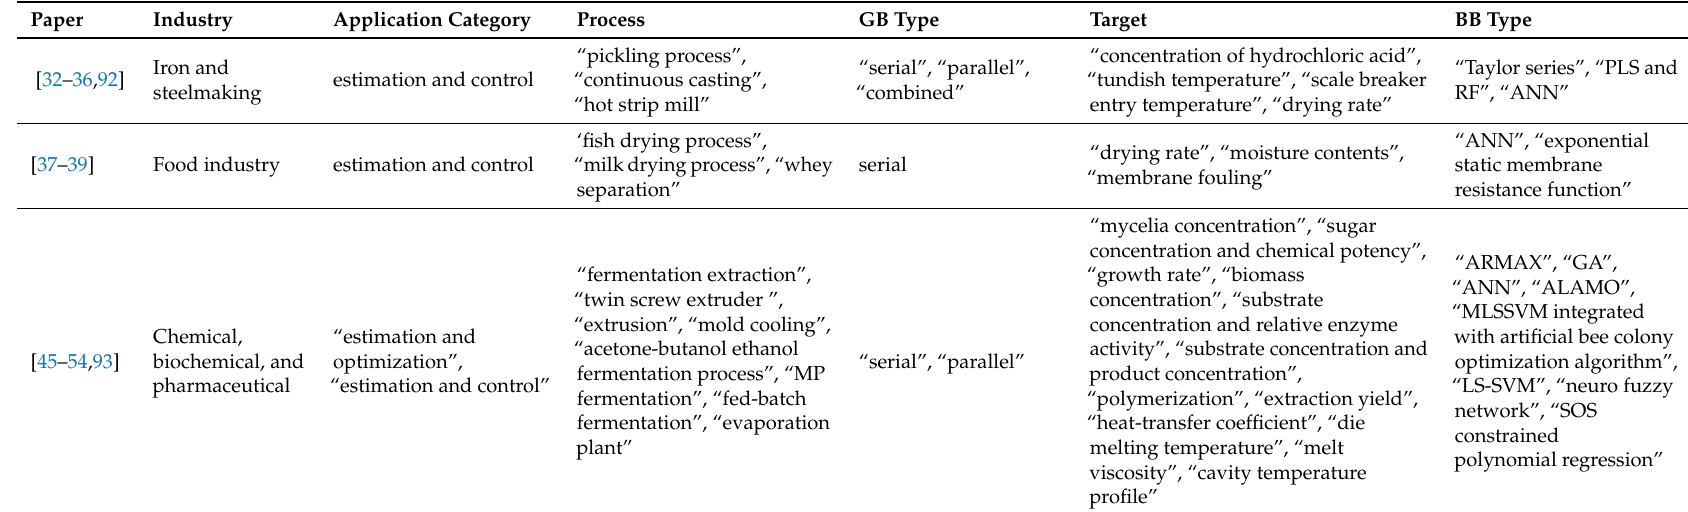
Table 1. GB models application in iron and steel, food processing, chemical, biochemical, and pharmaceutical